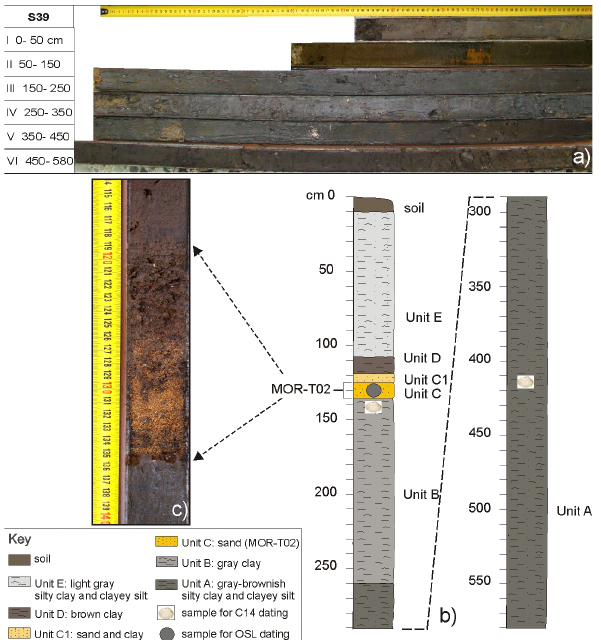
Fig. 4. (a) Photo of the S39 vibrocoring core collected at the Pan- tano Morghella. Core location is shown in Fig. 2a. Scale is in cm. Roman numbers indicate 1m cores from the top; cores II and VI are compressed. (b) S39 log representing stratigraphy of the Pan- tano Morghella central part; (c) core photo from 1.14m to 1.40m of depth. Please note the rip-up clasts in the sand